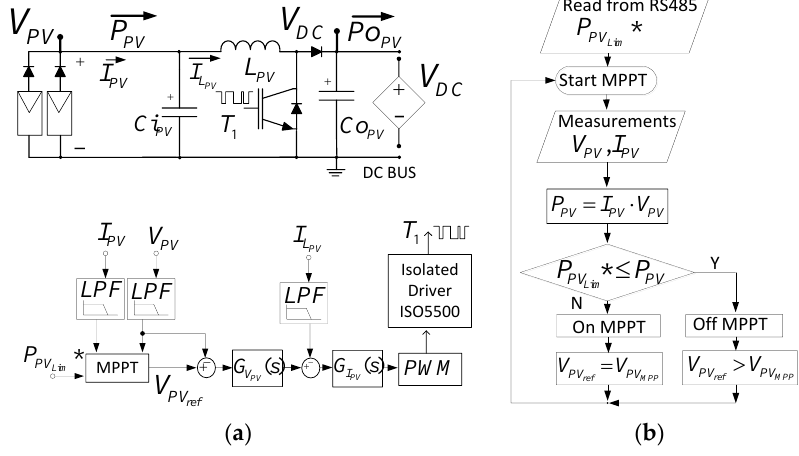
Figure 2. Topology and control of the PV system: ( a ) DC/DC converter; ( b ) Control strategy of the PV system.